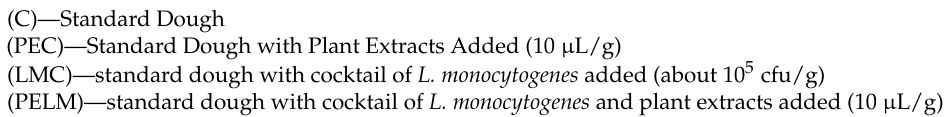
Table 1. Inoculation trials in sausages